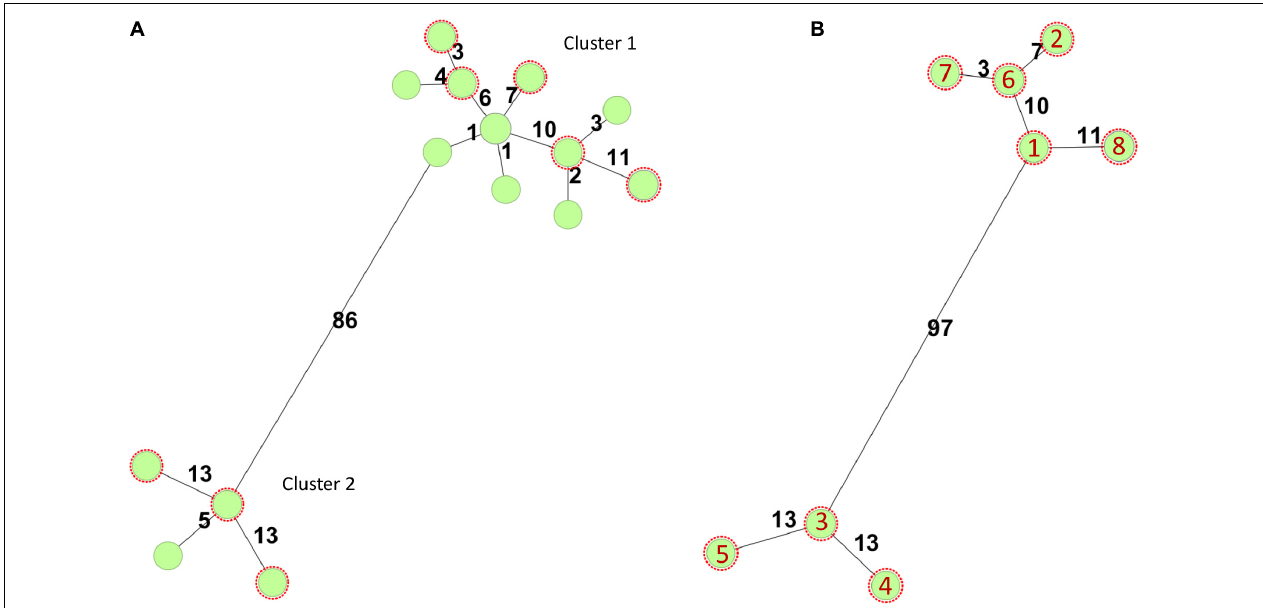
FIGURE 1 | Minimum-spanning trees based on core genome multilocus sequence typing (cgMLST) using the Escherichia / Shigella scheme v.1 (2,513 targets) from Enterobase run in SeqSphere+7.0.6 (Ridom GmbH, Münster, Germany). Number of allelic differences is shown on the connecting lines between the different strains. All STEC were of sequence type 342. (A) Minimum-spanning tree of 18 stx2a positive O145:H25 STEC strains whole genome sequenced at the National Reference Laboratory between 2007 and 2020. Two of the circles include two or three isolates, respectively. The O145:H25 STEC fell into two clusters (86 allelic differences). Cluster 1 contained 14 STEC from 2009 to 2020 and cluster 2 four STEC from 2007, 2011, and 2012. Both clusters harbored isolates from HUS cases. (B) Minimum-spanning tree of O145:H25 STEC ( n = 8) selected for in-depth analysis. Red numbers refer to the different isolates (with year of isolation in